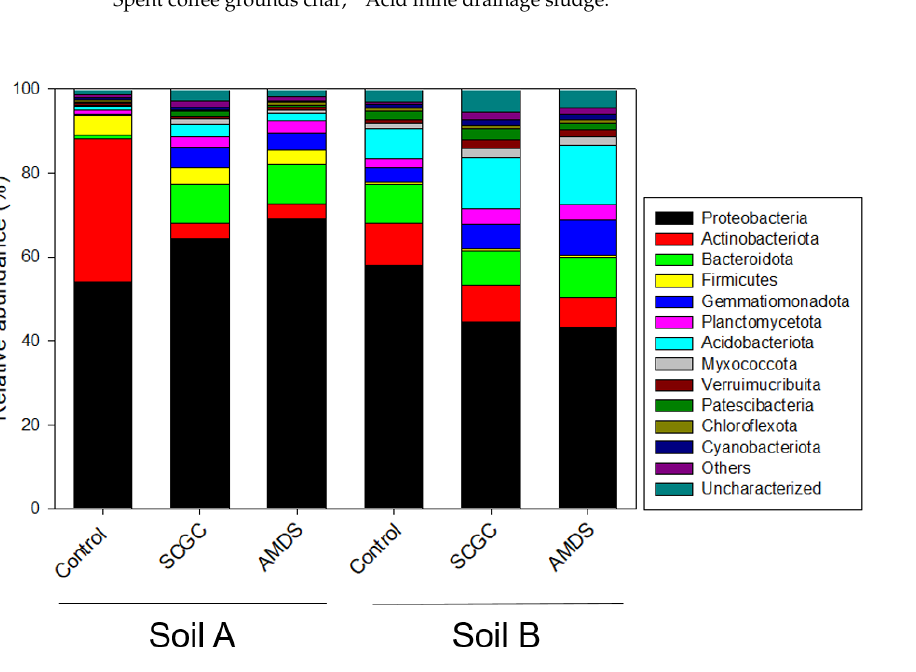
Figure 3. Comparison of the relative abundance of microbial consortium at the phylum level. Table 3. Number of operational taxonomic unit (OUT), estimated OUT richness (Chao 1), Shannon and Simpson diversity indices, and estimated sample coverage (Good’s coverage).